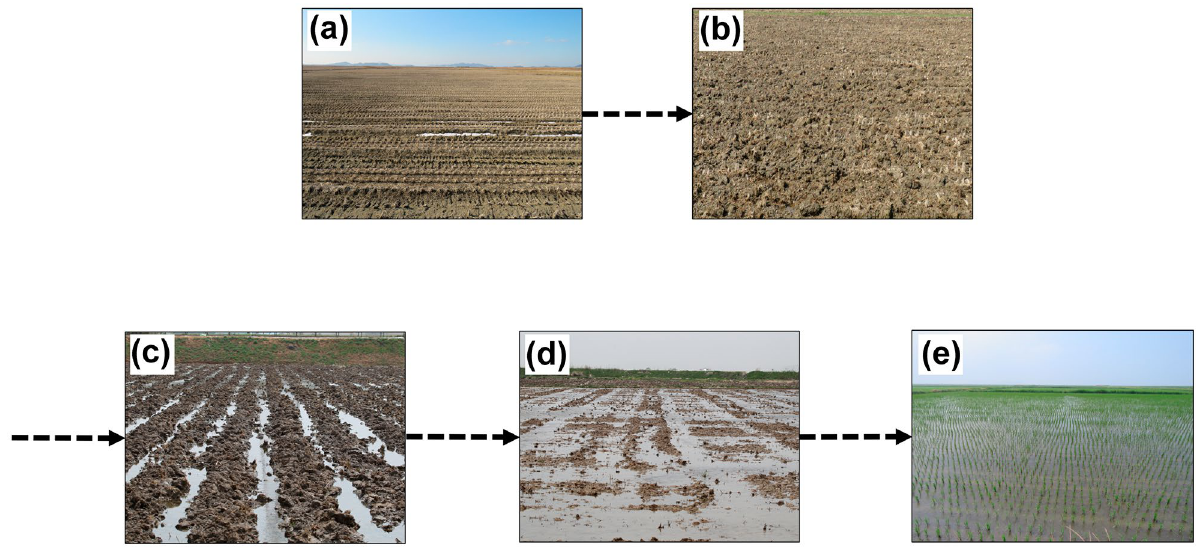
Figure 7. Progress of major changes in field types. Two types of paddy habitats observed at the study site before shorebird occurrence: ( a ) post-harvest and ( b ) plowed before filling with water. Three types of paddy habitats observed at the study site during the period of northward shorebird migration: ( c ) plowed paddy, ( d ) harrowed paddy, and ( e ) seeded